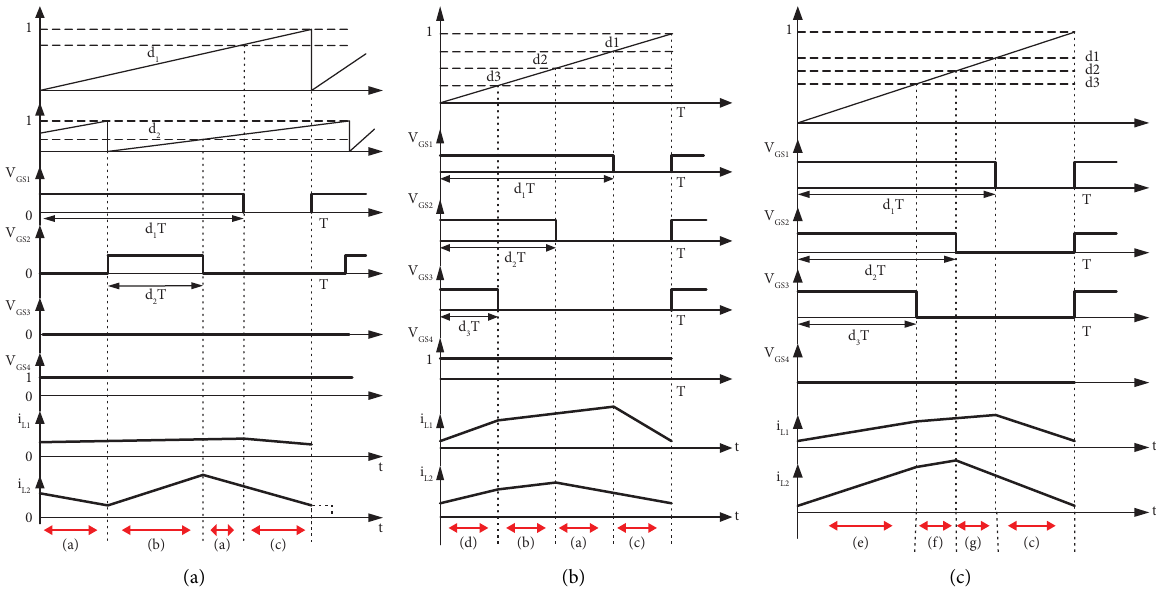
Figure 4: Te order of switching in all three modes: (a) First operation mode; (b) second operation mode; (c) third operation mode.